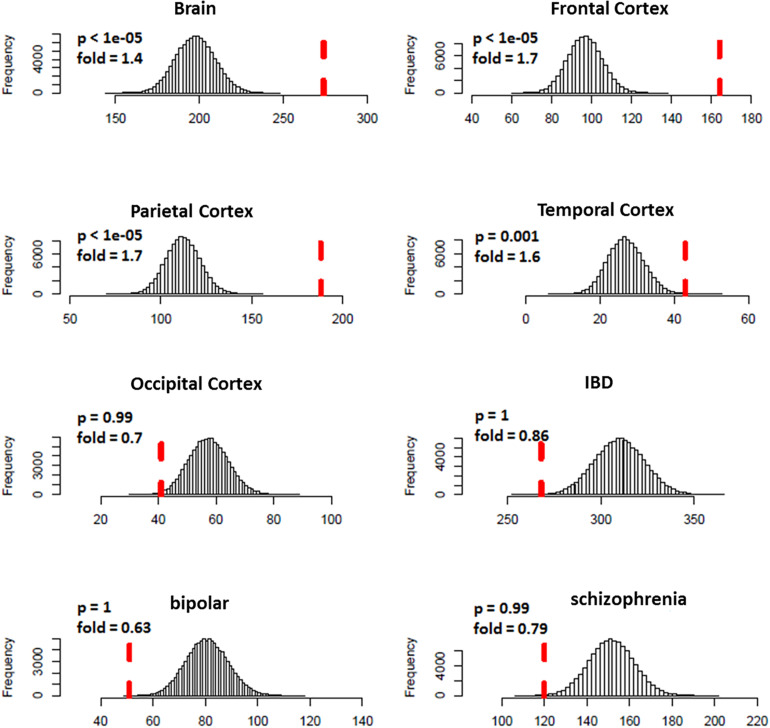
Enrichment analysis of differential expression evidence for predicted ASD risk genes. The histogram shows the distribution for the number of genes with DGE evidence (p < 0.05) from random gene sets. The vertical dotted red line indicates the number of genes with DGE evidence from predicted ASD risk genes. Predicted risk genes tended to be down-expressed in brains of ASD, but not for disorders of negative control (IBD, bipolar disorder, and schizophrenia).